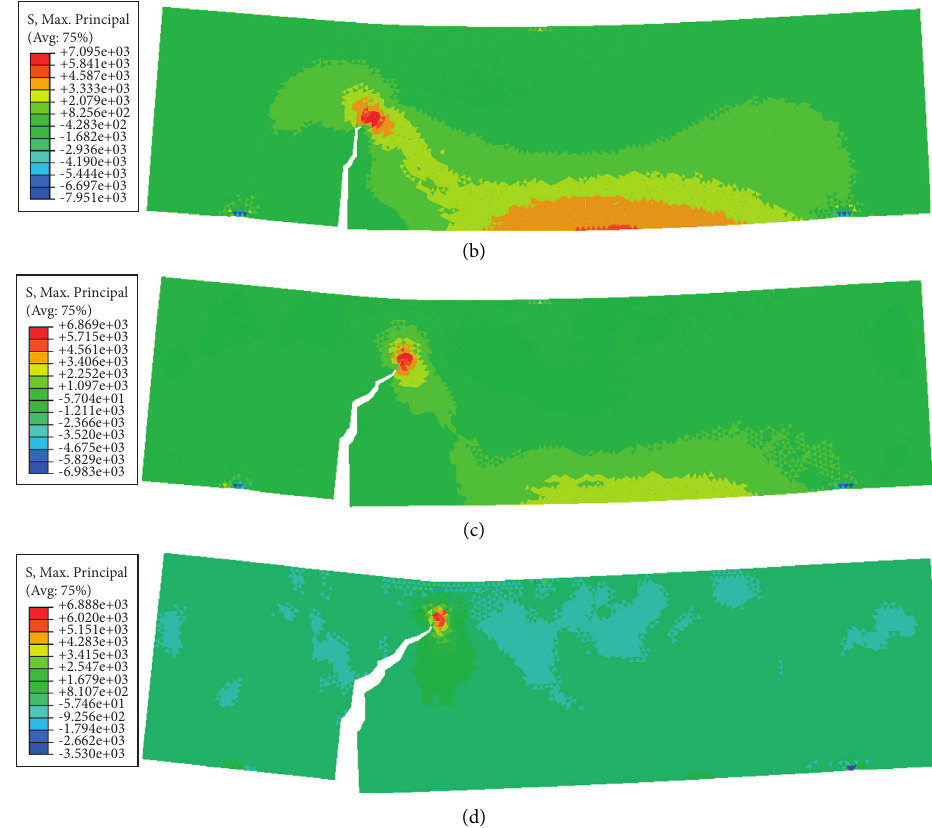
Figure 18: The MPSN of the crack propagation process using FDEM. (a) Initial stage; (b) early stage; (c) mid-late stage; and (d) complete crack stage of crack propagation